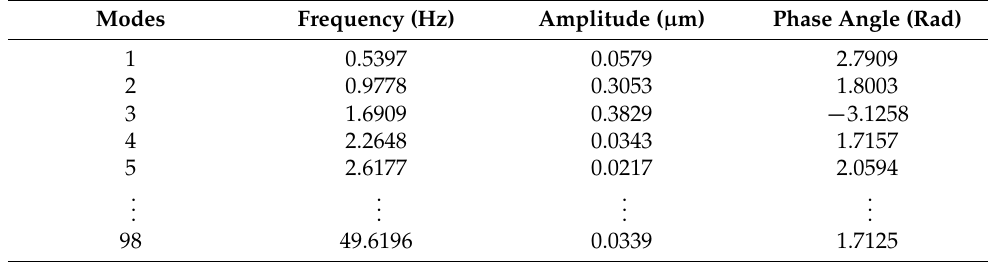
Table 11. Modal parameters of real-time signal identified with Prony approach.